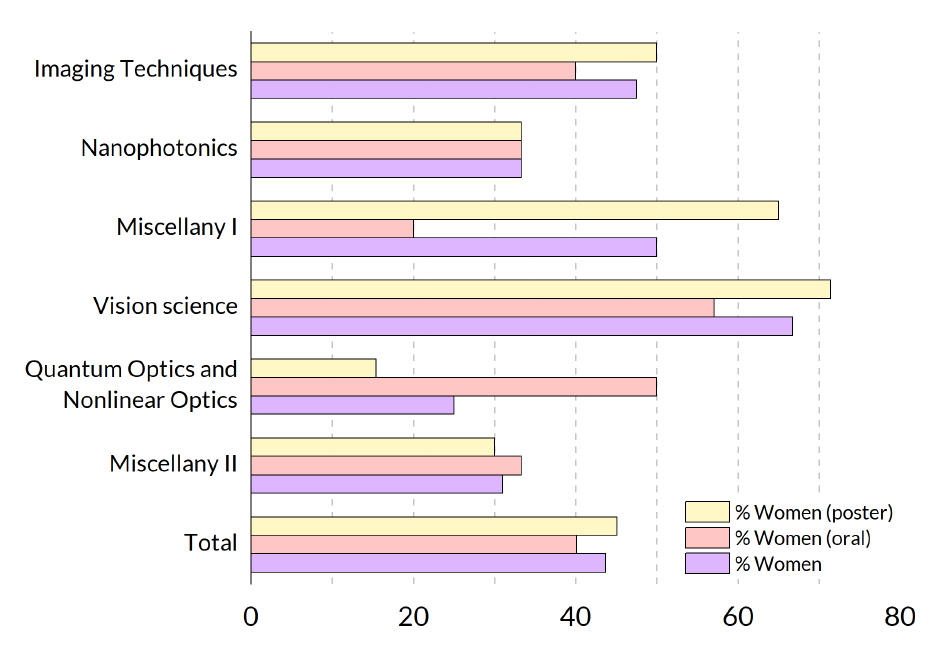
Figure 4. Percentage of women as presenting authors in posters and oral talks (by